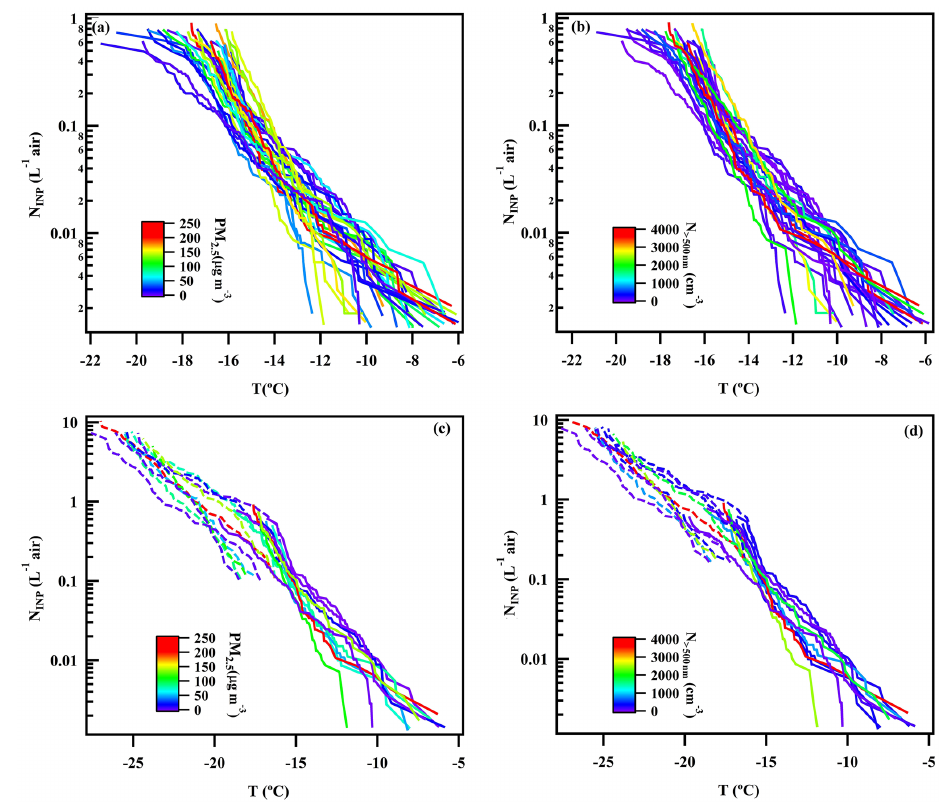
Figure 5. N INP as a function of temperature. Panel (a) and (b) show INDA results colored by PM 2 . 5 mass concentration and 12h average N > 500nm , and panel (c) and (d) show 10 comparable results of INDA and LINA colored by PM 2 . 5 mass concentration and 12h average N > 500nm . Dotted lines represent LINA results, while solid lines represent INDA results.